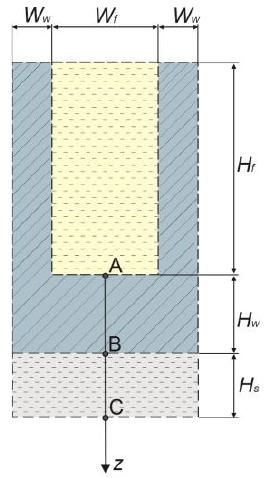
Figure 2. One-dimensional model of the microfluidic system.